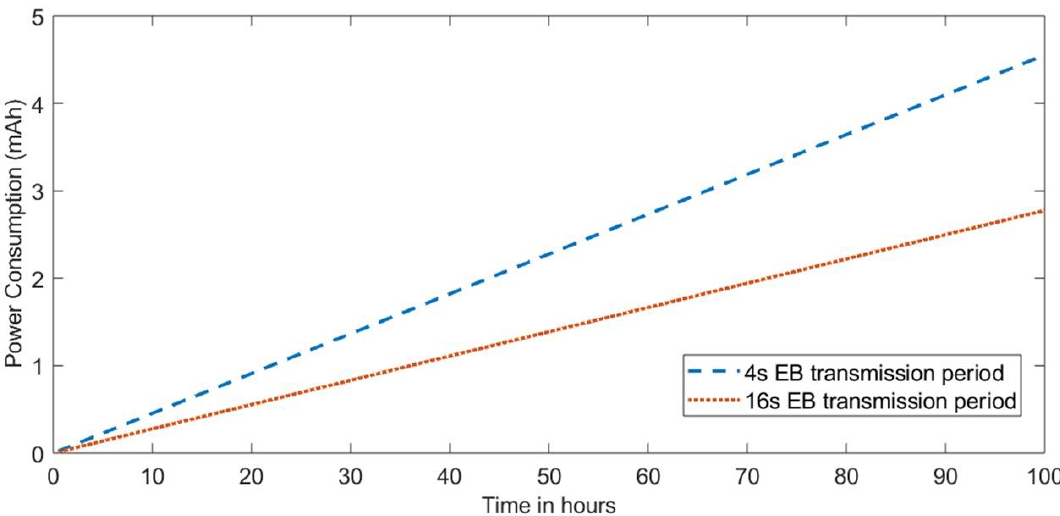
Figure 14 . The power consumption for different EB periods over 100 h. Figure 14. The power consumption for different EB periods over 100